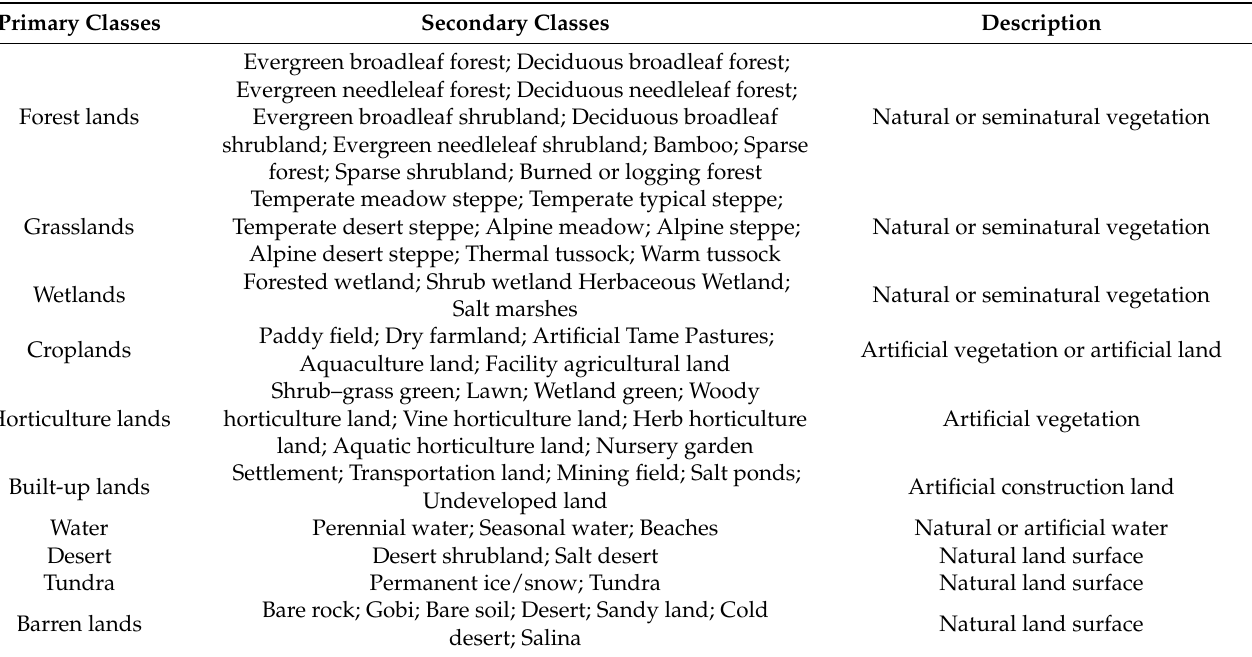
Table 1. ChinaCover land cover classification system and